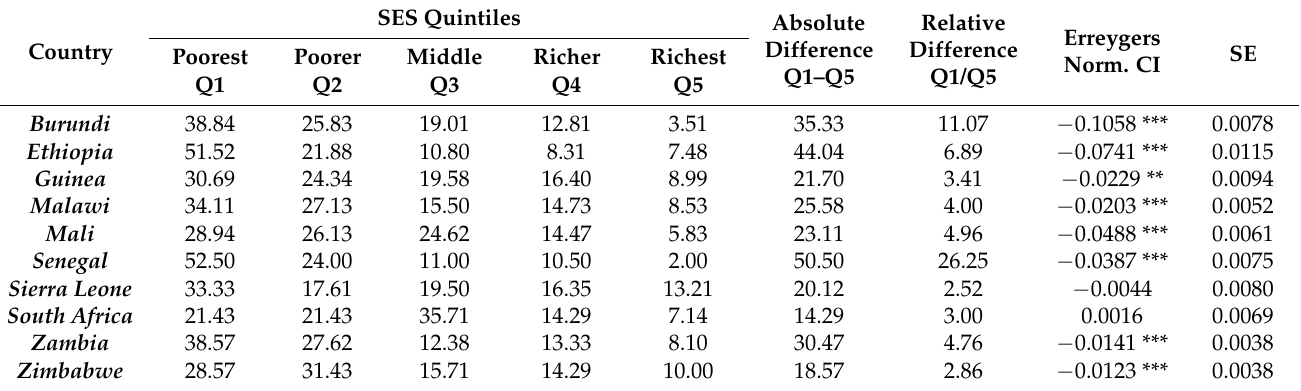
Table 5. Estimated prevalence of underweight among children by socio-economic status (SES) quintile.